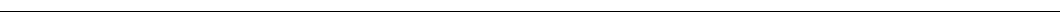
Fig. 3 ZIKV-3 ′ UTR- Δ 10-LAV and ZIKV-3 ′ UTR- Δ 20-LAV protect rhesus macaques (RMs) from ZIKV infection. a Scheme of immunization of RMs with 10 3 FFU of WT ZIKV strain FSS13025 ( n = 4), ZIKV-3 ′ UTR- Δ 10-LAV ( Δ 10; n = 4), ZIKV-3 ′ UTR- Δ 20-LAV ( Δ 20; n = 3), ZIKV-NS1-LAV or PBS sham ( n = 2) via the subcutaneous route. b Viremia was measured at days 2, 3, 4, 5, 7, and 10 post immunization by qRT-PCR. Each colored line represents data from a different animal in each group. The dashed line indicates the limit of detection (LOD) of the assay. c Pre- and post-challenge antibody neutralization titers. On various days post immunization, sera were measured for neutralizing titers using an mCherry ZIKV infection assay. Red arrows indicate challenge with 10 3 FFU of epidemic ZIKV strain PRVABC59 via the subcutaneous route at day 56 post immunization. The number of animals whose antibody neutralization titers increased by ≥ 4-fold after challenge is indicated by symbol “ ↑ ” for each experimental group. d Post-challenge viremia. Viremia was measured by qRT-PCR at days 2, 3, 4, 5, 7, and 10 post challenge. All negative samples are plotted at the half value of LOD. Error bars represent